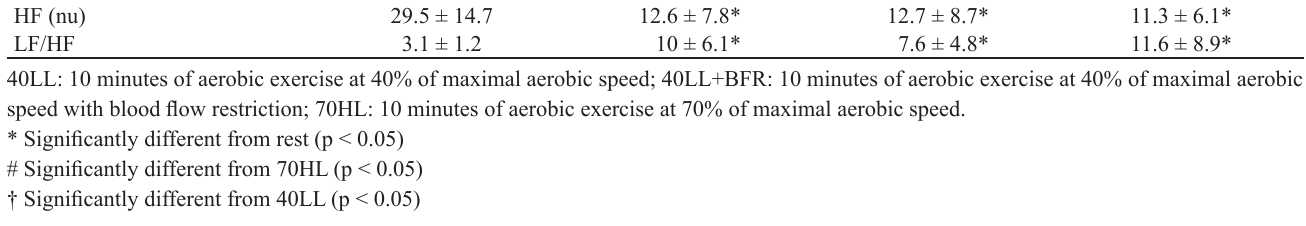
Table 4. Mean and SD of systolic and diastolic blood pressure at 5th and 10th min of recovery after constant load aerobic exercise for each experimental condition.